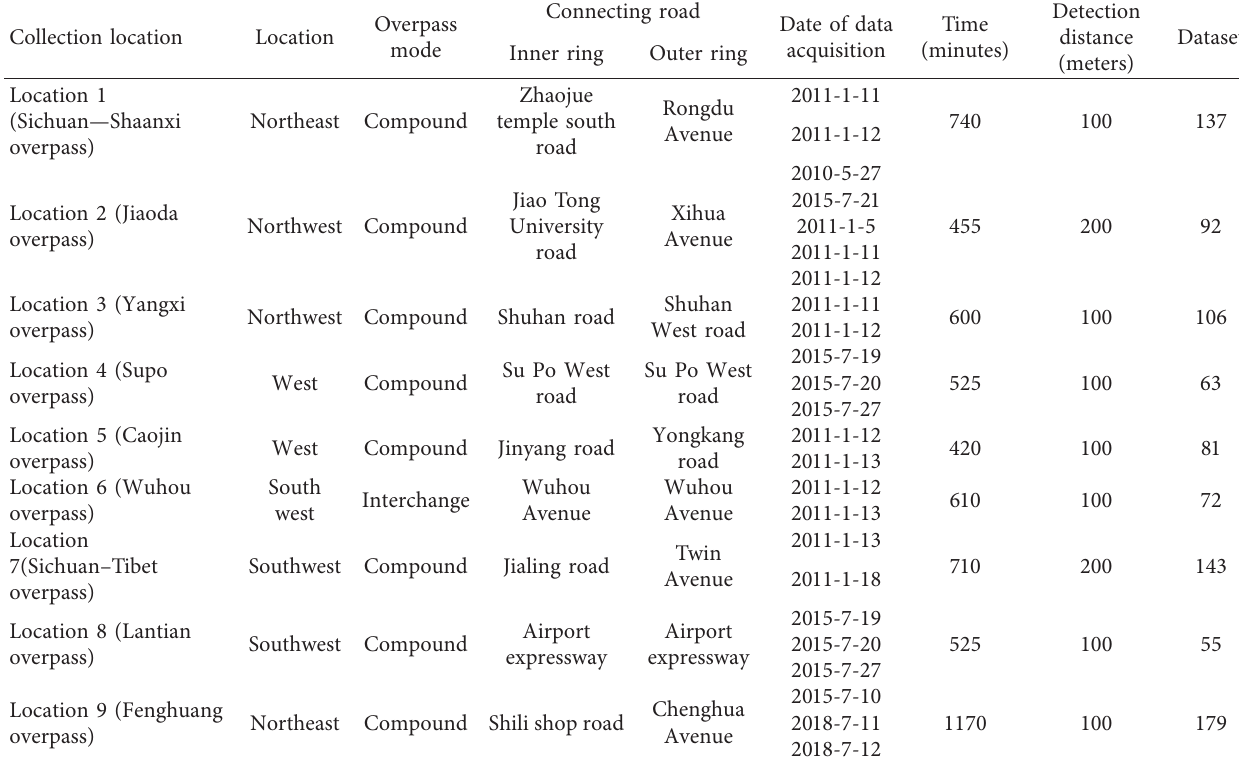
Figure 2: The sketches of connection and linear section. (a) The sketch of the connecting overpass and straight linear section. (b) The sketch of connecting overpass and bend linear section. (c) The sketch of connecting straight linear section. (d) The sketch of connecting bend linear section. Table 1: Introduction of each collection